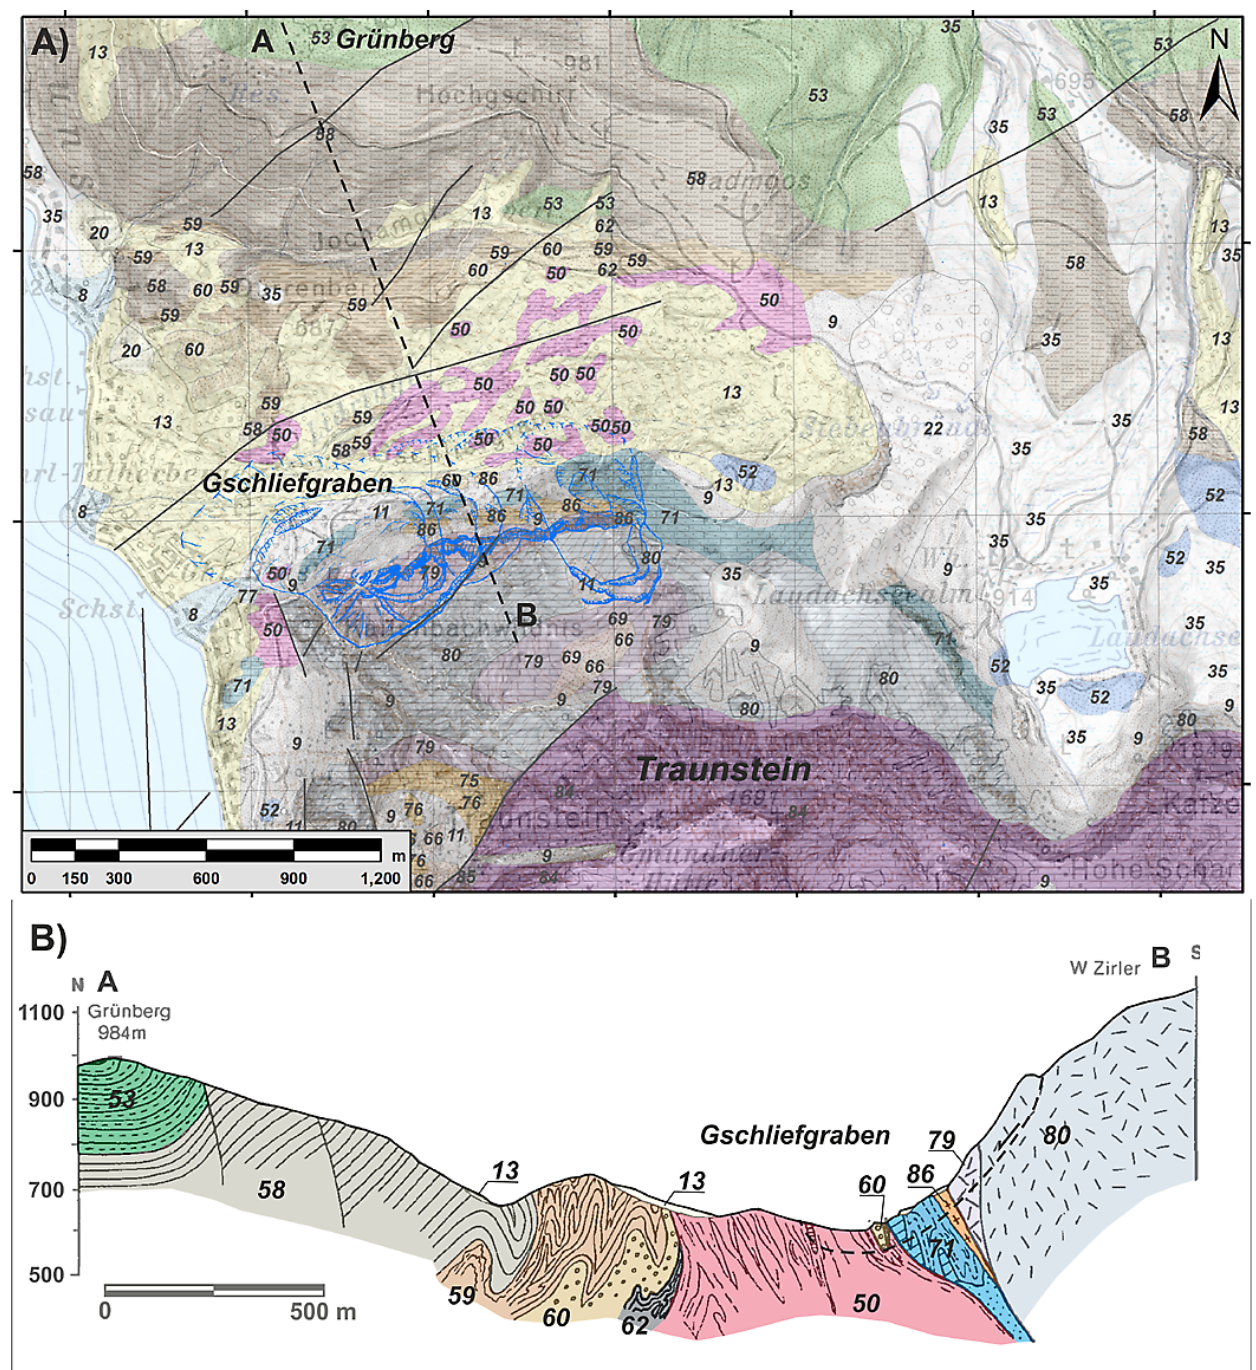
Fig. 3. Geological map of the area of Gschliefgraben. The blue contours indicate the deep-seated gravitational deformations. Legend: Qua- ternary deposits: 8 – alluvial fan, 9 – slope scree, 11 – block fields, 13 – landslide deposits, 20 – Glaciolacustrine deposits, 22 – slope breccia, 35 – moraine deposit; UHV: 50 – Buntmergelserie, 52 – Gresten Fm.; RFZ: 53 – Altlengbach Fm., 58 – Zementmergel Fm., 59 – Seiesenburg Fm., 60 – Rieselsberg Fm., 62 – Gaultflysch Fm.; NCA: 66 – Schrambach Fm., 69 – Ruhpolding Fm., 71 – Calcarenite Fm., 75 – Koessen Fm., 76 – Koessen Fm., 77 – Koessen Fm., 79 – Plattenkalk Fm., 80 – Hauptdolomit Fm., 84 – Wetterstein Fm., 85 – Guttenstein Fm., 86 – Haselgebirge Fm.; the major tectonic faults are represented by solid lines (modified after Schoenlaub et al., 1996; Krenmayr, 2007 and Moser,